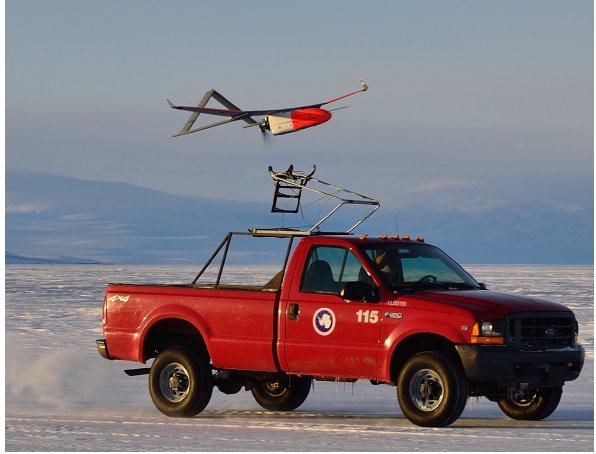
Figure 2. The Aerosonde UAS being launched from a truck at Pe- gasus Field (photo: J. Cassano).